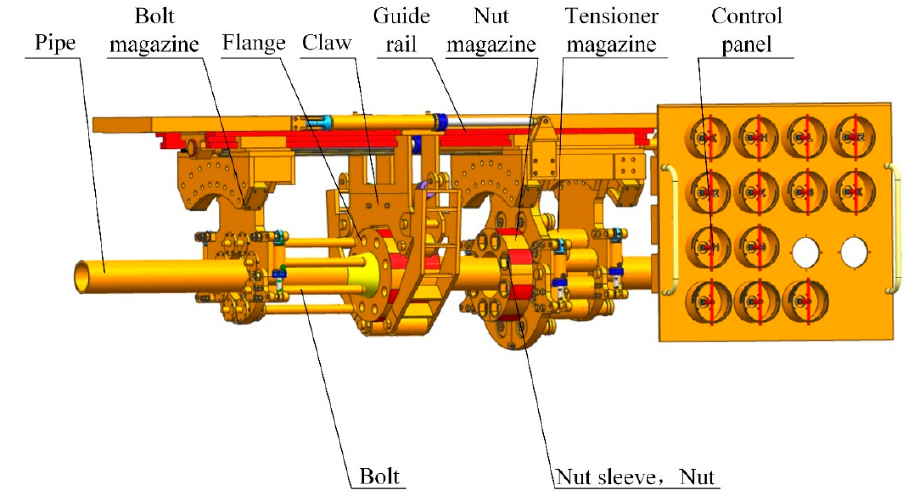
Figure 1. Deep-water bolt flange automatic connection tool.